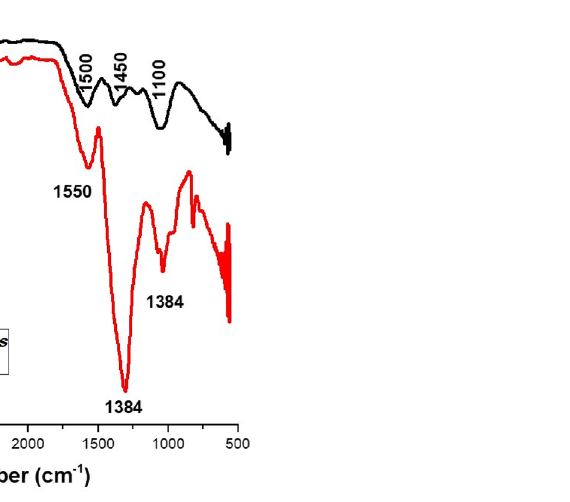
Figure 2. FTIR spectra of C. procumbens extract and